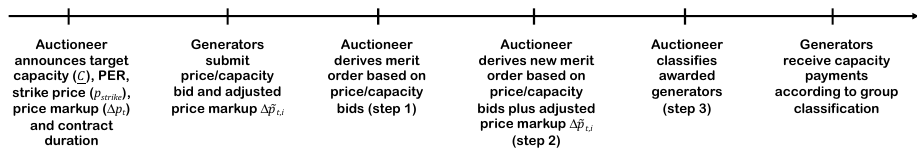
Figure 2. A simplified sequence of events of the stepwise procedure leading to the classification of groups of power plant operators.